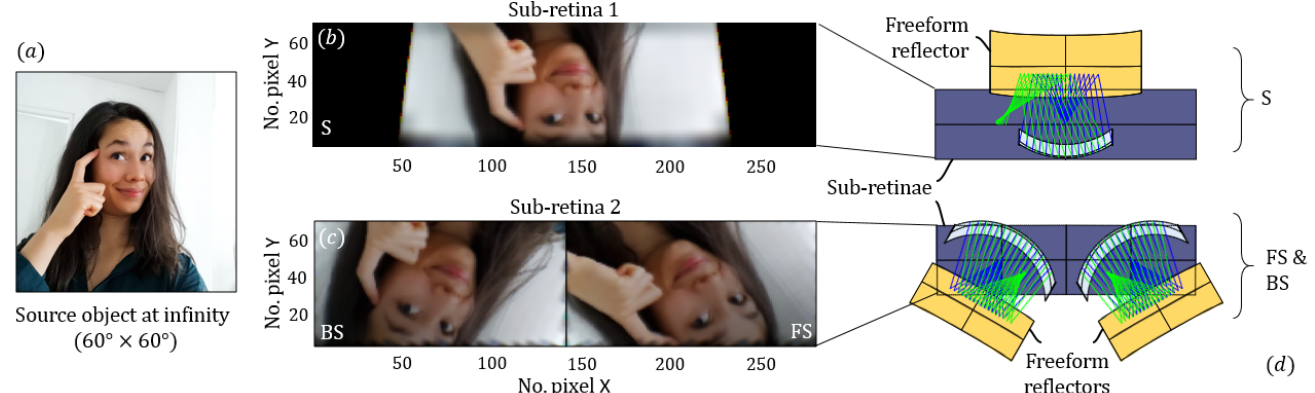
Figure 7. ( a ) Example picture as a source object at infinity. ( b ) Simulated images obtained with the S subsystem on the first sub ‐ retina and ( c ) with the FS and BS subsystems sharing the second sub ‐ retina. ( d ) Schematic top ‐ view of the three subsystems aligned with the two sub ‐ retinae.